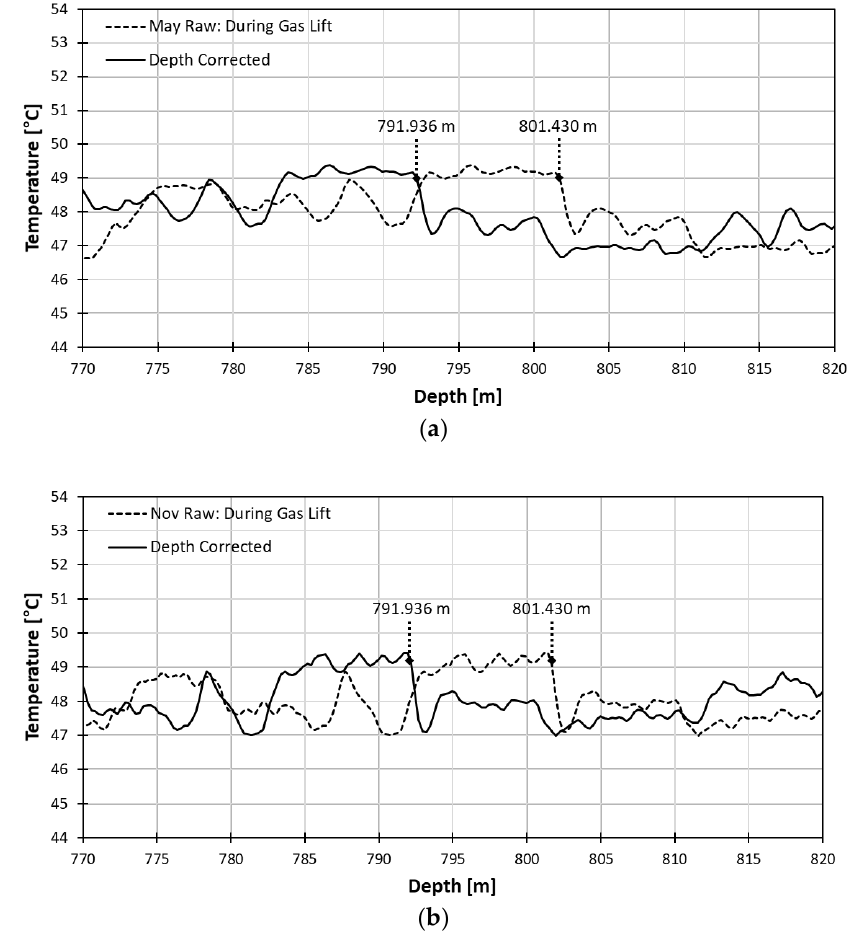
Figure 4. Comparison of depth correction effect with gas lift data from May ( a ) and November ( b ).